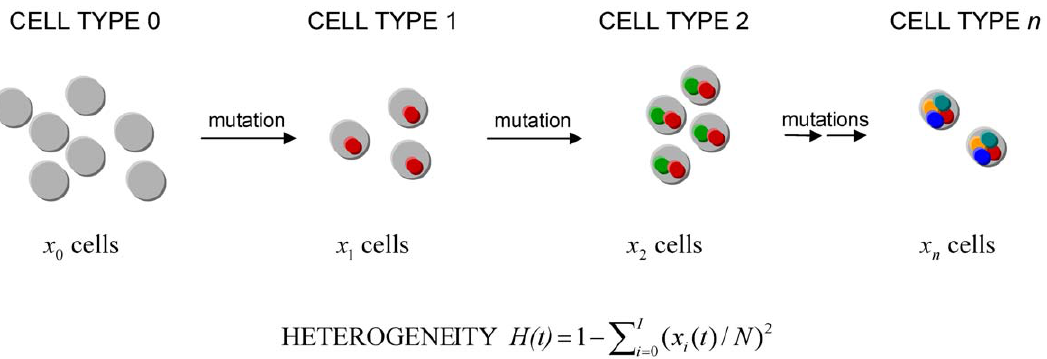
Figure 1. A mathematical model of tumor heterogeneity. We consider a population of N tumor stem cells which accumulate mutations. Each time a mutational event occurs, a new cell type is created. Cell types are enumerated i =0, 1, …, I . The extent of heterogeneity at time t is measured by Simpson’s index shown below, which incorporates the number of cells of each type at time t , x i ( t ) , and the total number of cells, N .